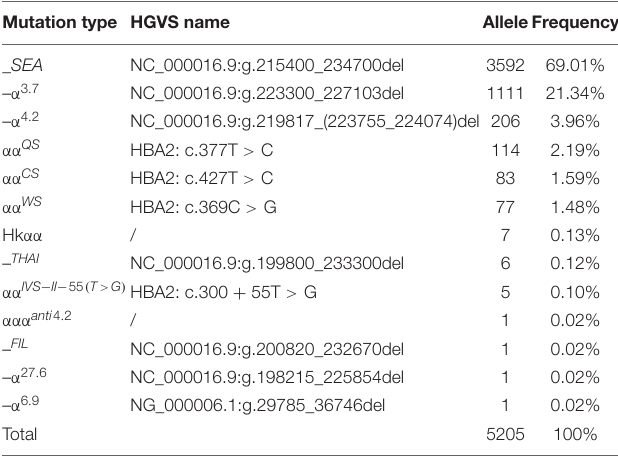
TABLE 5 | Allele frequency of α -thalassemia mutations in Quanzhou Prefecture. TABLE 6 | Allele frequency of β -thalassemia mutations in Quanzhou